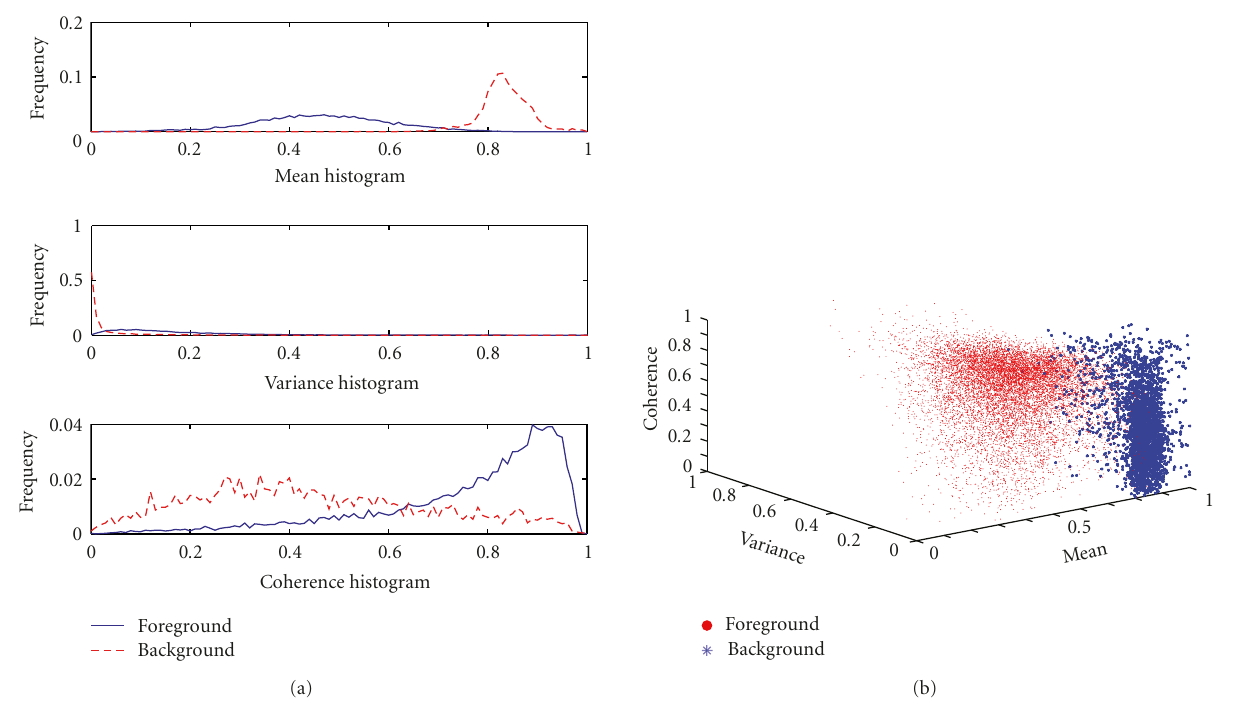
Figure 3: CMV histograms and distribution of the 10 fingerprints in FVC2000